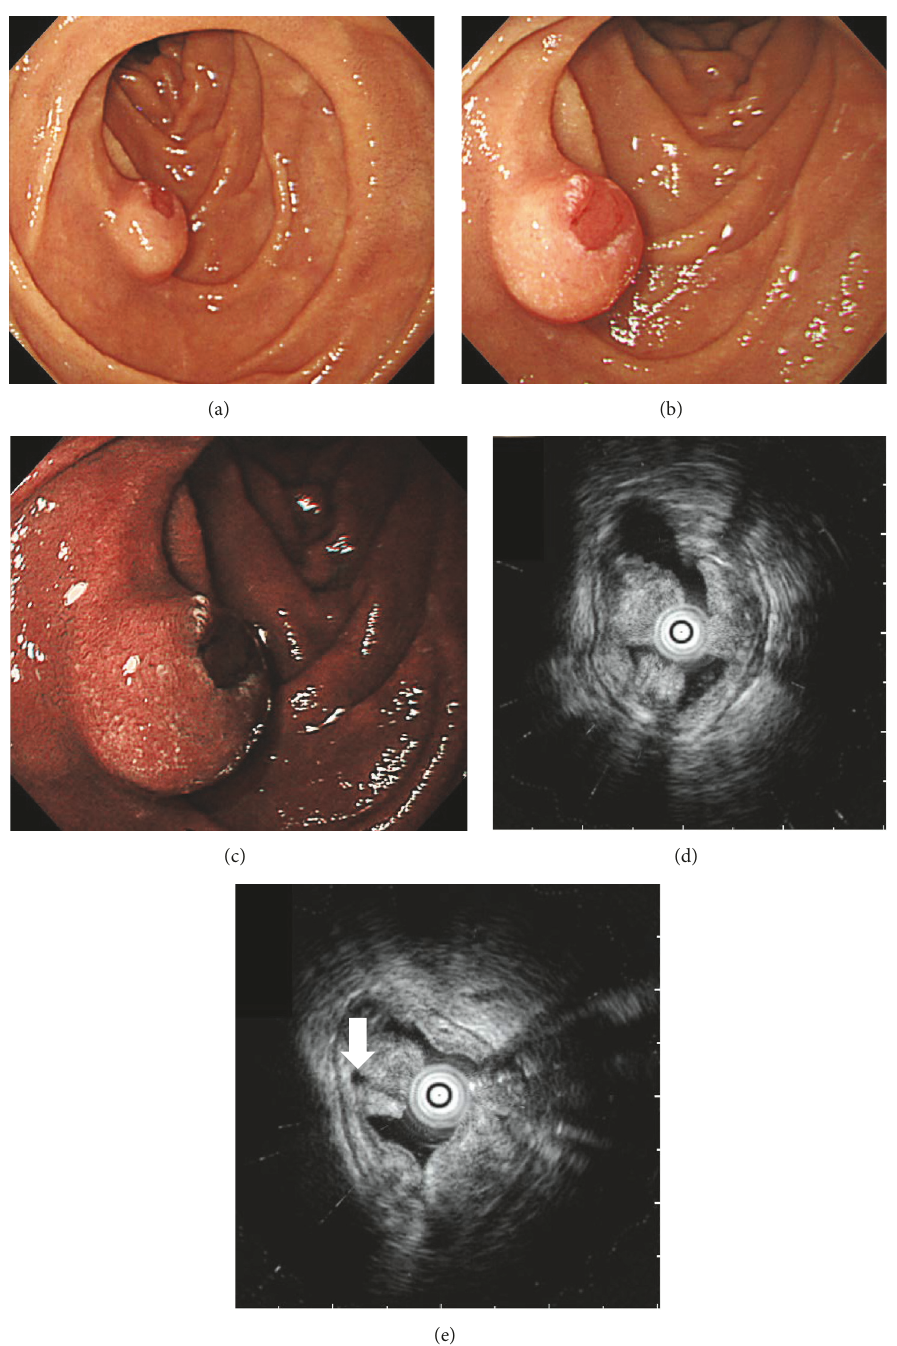
Figure 1: Endoscopic images. Esophagogastroduodenoscopy shows a solitary submucosal tumor in the duodenal second portion. The top of the tumor is slightly depressed, showing a reddish color on white light imaging (a, b) and a brownish color on narrow band imaging (c). Endoscopic ultrasonography reveals that the hypoechoic mass is mainly confined to the mucosal layer (d). A small cystic area is also seen (white arrow)